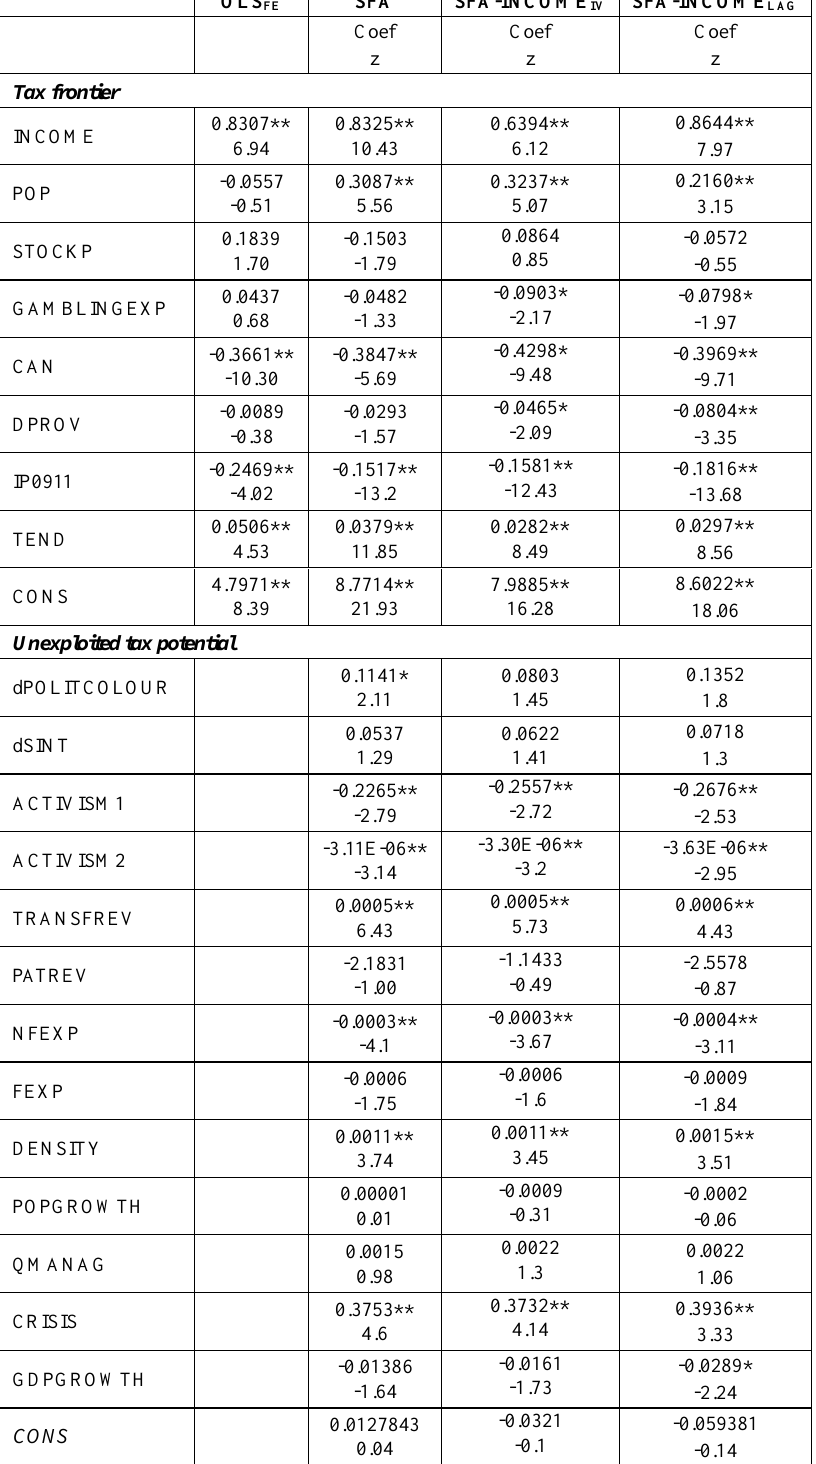
Table 2 : Results of the estimates of tax